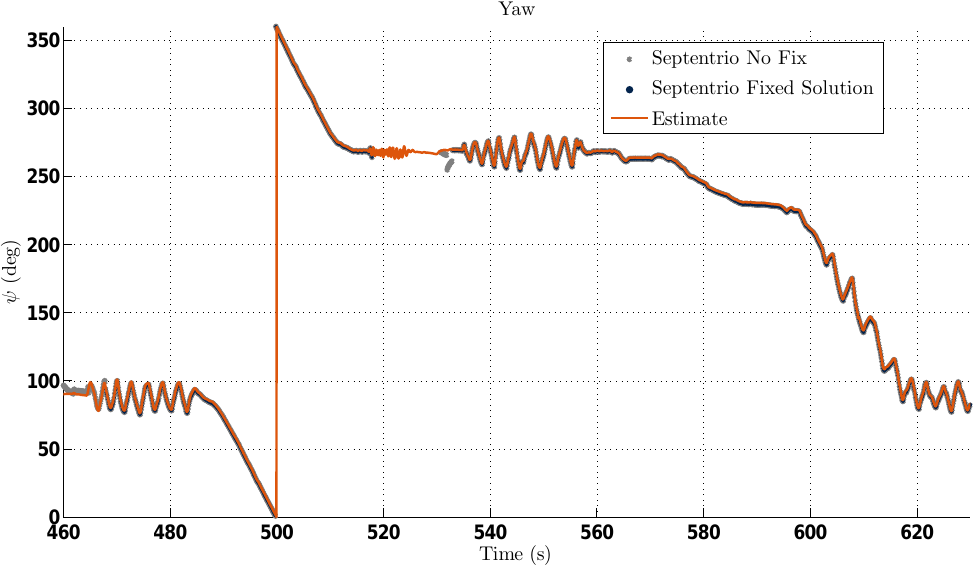
Figure 13. Yaw comparison on the NCAT oval track 16-state coupled